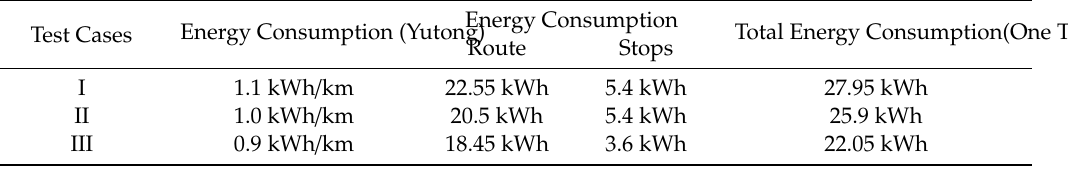
Table 3. One trip energy consumption for Skybus (airport to